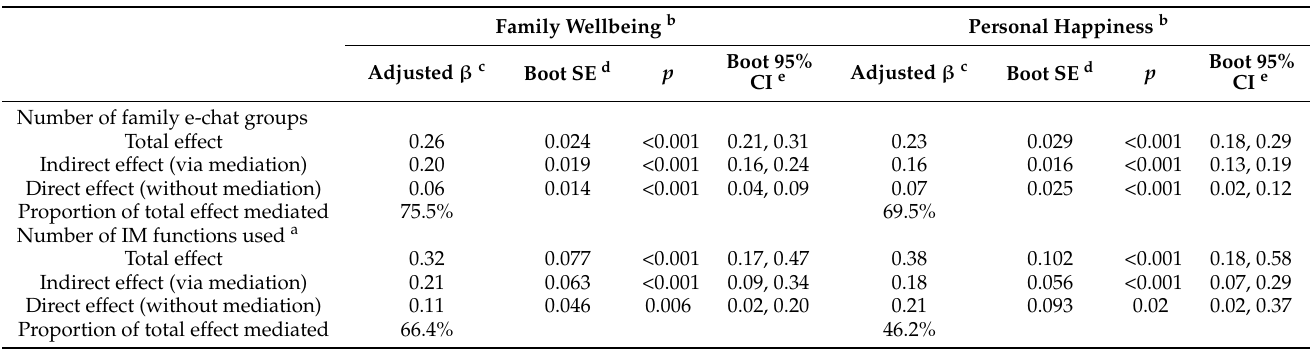
Table 6. Adjusted indirect, direct, and total effect of number ( n = 4890) of family e-chat groups and IM functions used ( n = 4046) a on family wellbeing and personal happiness mediated by family communication